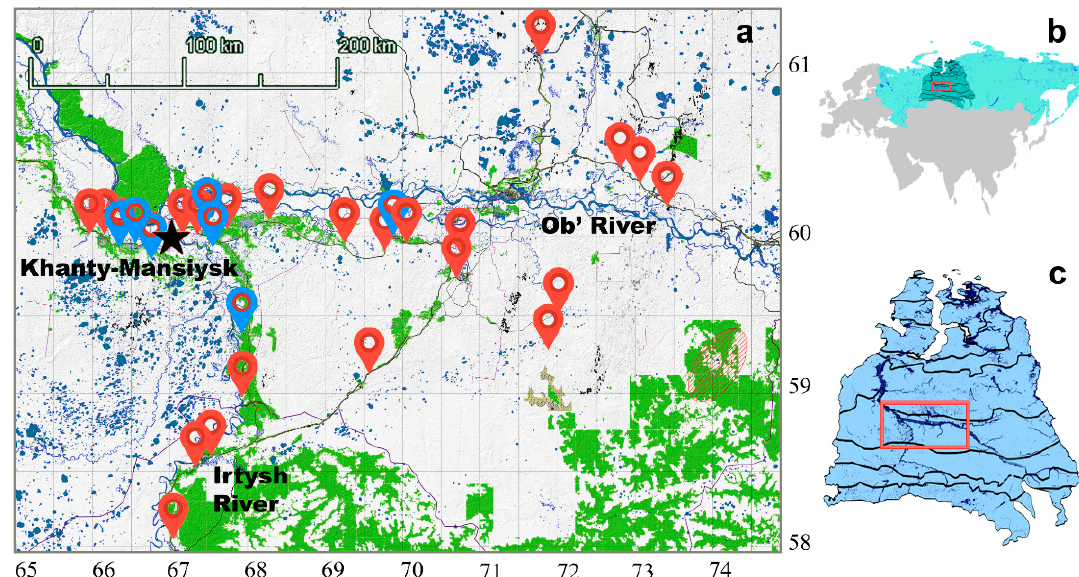
Figure 2. Study region in West Siberia: ( a ) red points correspond to seep areas where ground-truth data were collected during field reconnaissance, blue points correspond to seep areas that were also extensively investigated using UAV; ( b ) the study region (red box) within Eurasia; ( c ) the study region (red box) within West Siberian Plain, black lines denote sub-biomes..